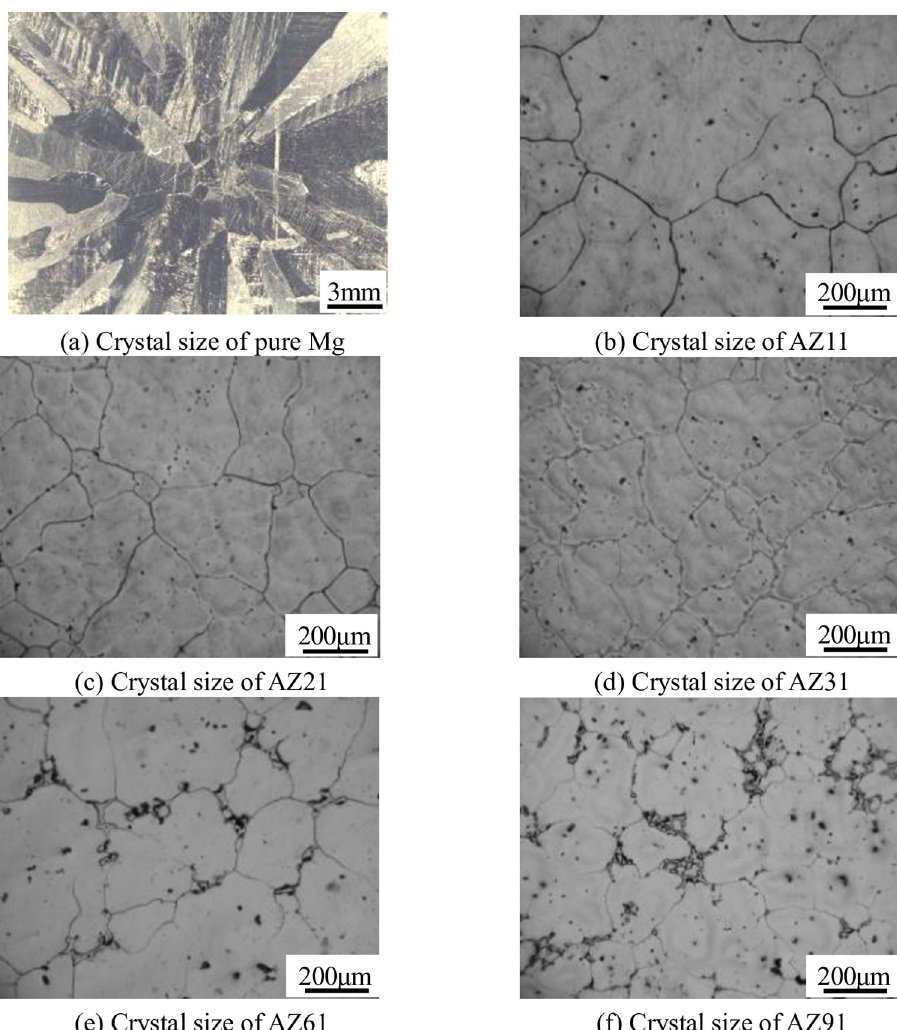
Fig 2. Microstructure of Mg-Al alloys with different Al contents without refinement. (a) Crystal size of pure Mg; (b) Crystal size of AZ11; (c) Crystal size of AZ21; (d) Crystal size of AZ31; (e) Crystal size of AZ61; (f) Crystal size of